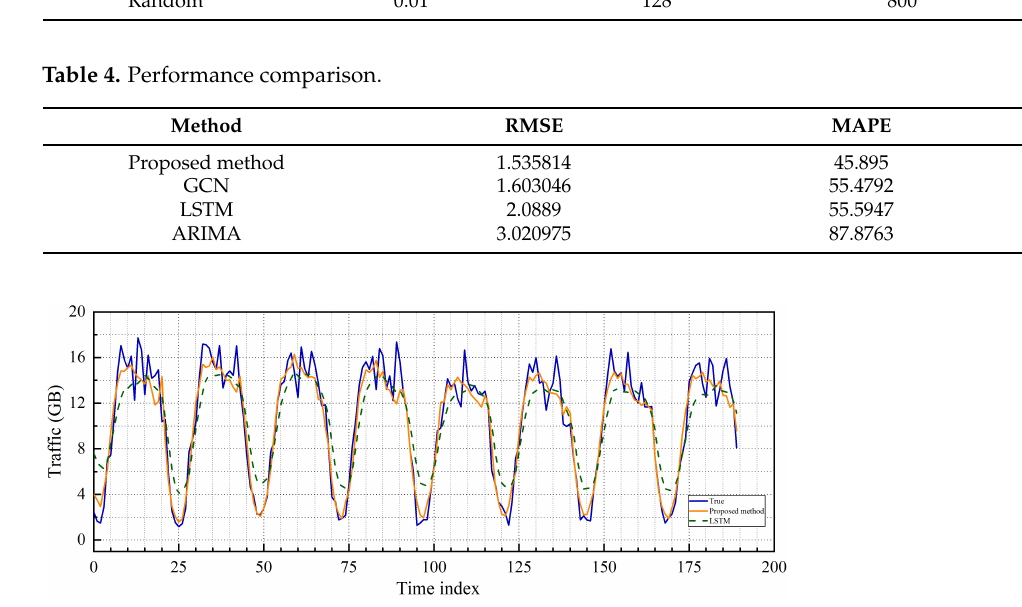
Figure 14. Prediction comparison of a certain